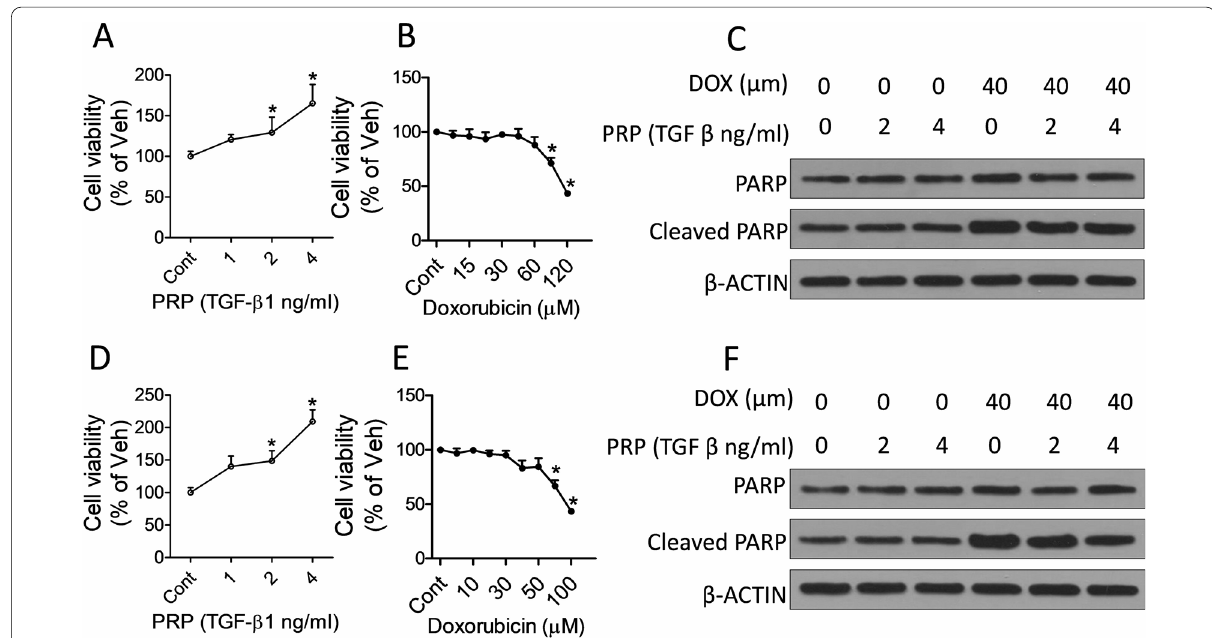
Fig. 2 PRP inhibits doxorubicin-induced chondrocyte apoptosis. ATDC5 cells and primary articular chondrocytes were treated with elevated concentrations of PRP and 40 doxorubicin for 24 h. A , B CCK-8 assay to determine ATDC5 viability after PRP ( A ) or doxorubicin ( B ) treatment. C Western blot assay to detect protein levels of PARP and cleaved PARP in ATDC5 cells. D , E CCK-8 assay to determine the viability of primary articular chondrocyte cells treated with PRP ( D ) or doxorubicin ( E ). F Western blot assay to detect protein levels of PARP and cleaved PARP in primary articular chondrocyte cells. At least three independent experiments were performed. * p < 0.05 vs control